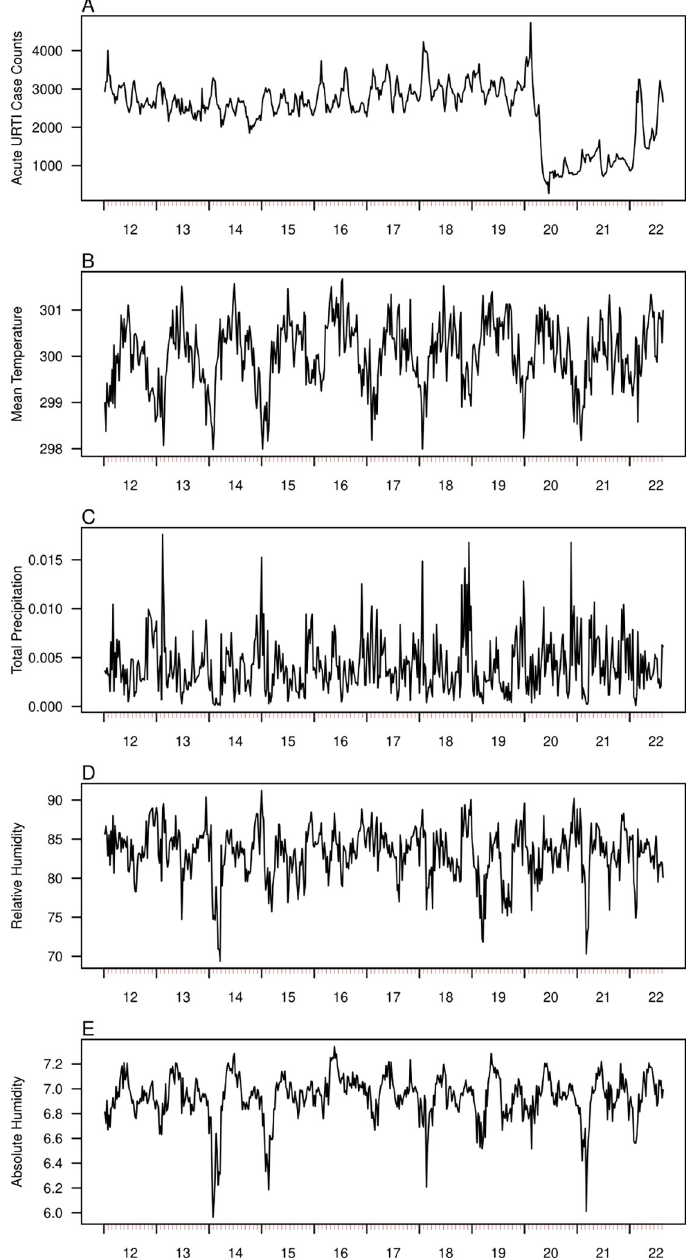
Fig 1. Weekly time series data from epiweek 1 2012 to epiweek 35 2022 on (A) average daily polyclinic attendances for upper respiratory tract infections (URTIs), (B) mean temperature (Kelvin), (C) mean total precipitation (Metres), (D) mean relative humidity (%) and (E) mean absolute humidity (in g/m 3